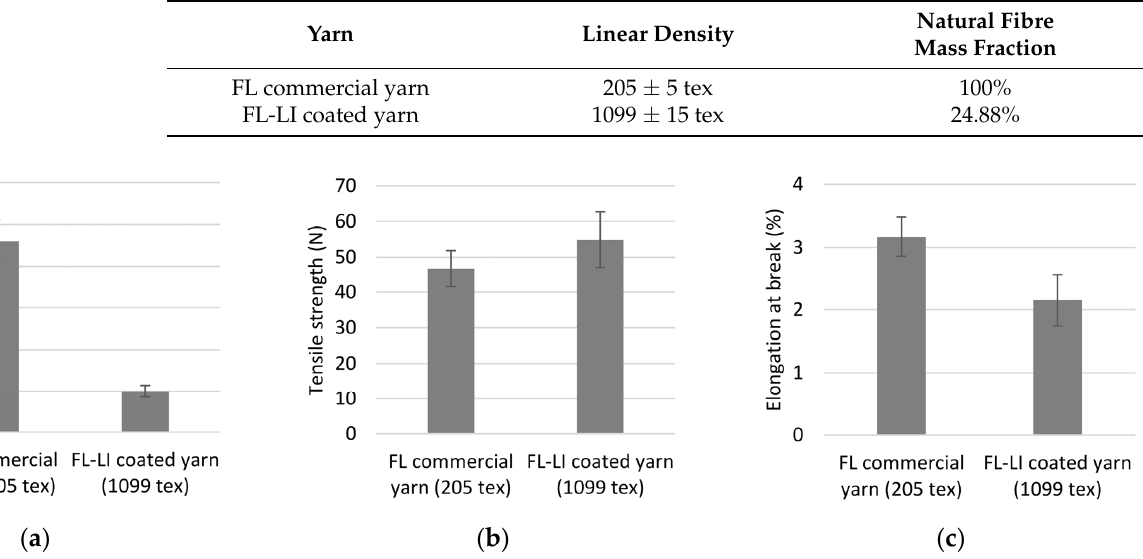
Figure 7. ( a ) Fineness-related tensile strength of yarns; ( b ) tensile strength of yarns ( c ) elongation at break of yarns.